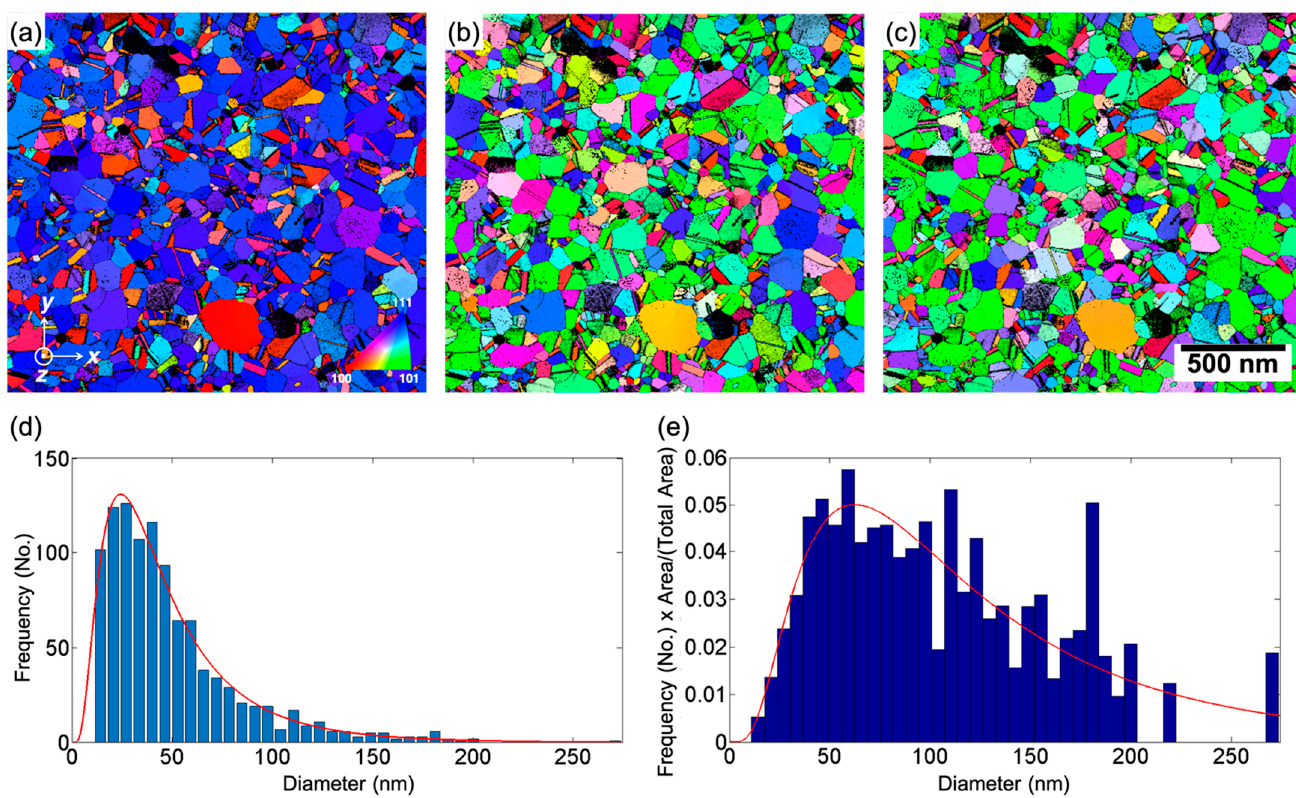
Figure 1. Inverse pole figure color maps showing the crystallographic orientations along the ( a ) z -, ( b ) x -, and ( c ) y -axes according to the coordinate system shown in ( a ), ( d ) number and ( e ) area weighted grain size distribution.